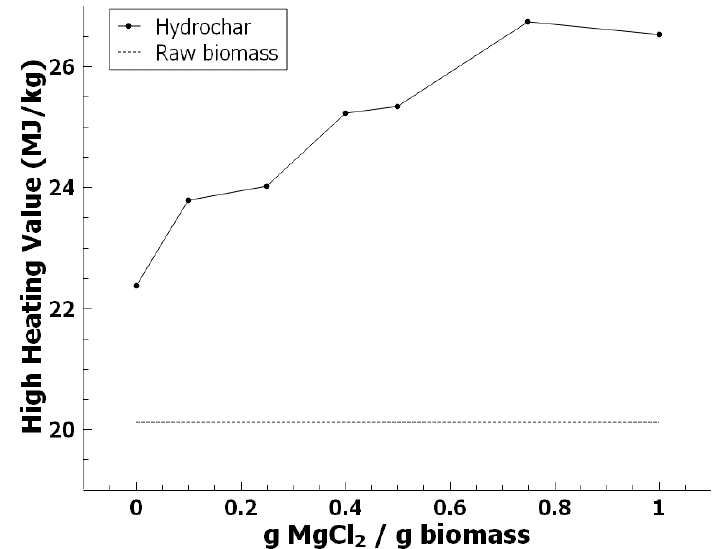
Figure 3. E ff ect of magnesium chloride on higher heating value (HHV) (all the analyses performed in triplicate and average values are plotted; standard deviation ≤